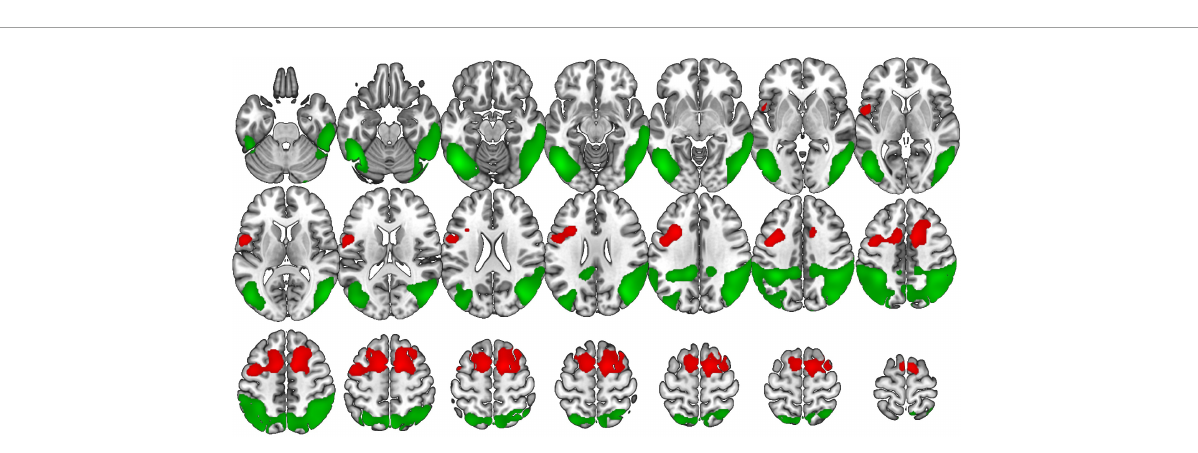
FIGURE5 Voxel-based brain mapping analysis showing the correlation between ROCP (copy accuracy) and brain metabolism in bvFTD (red) and AD (green) (FWE-cluster corrected p -value < 0.05). Images are shown in neurological orientation (Left is left hemisphere, right is right